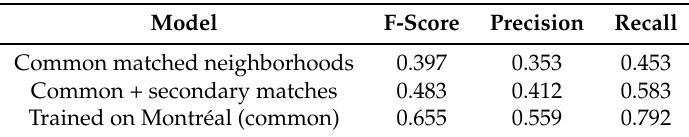
Table 6. F-score, precision and recall values for two random forest models trained on listings from Washington, DC, and tested on listings from Montréal, QC. The last row shows the results of a model trained and tested on listings from Montréal,